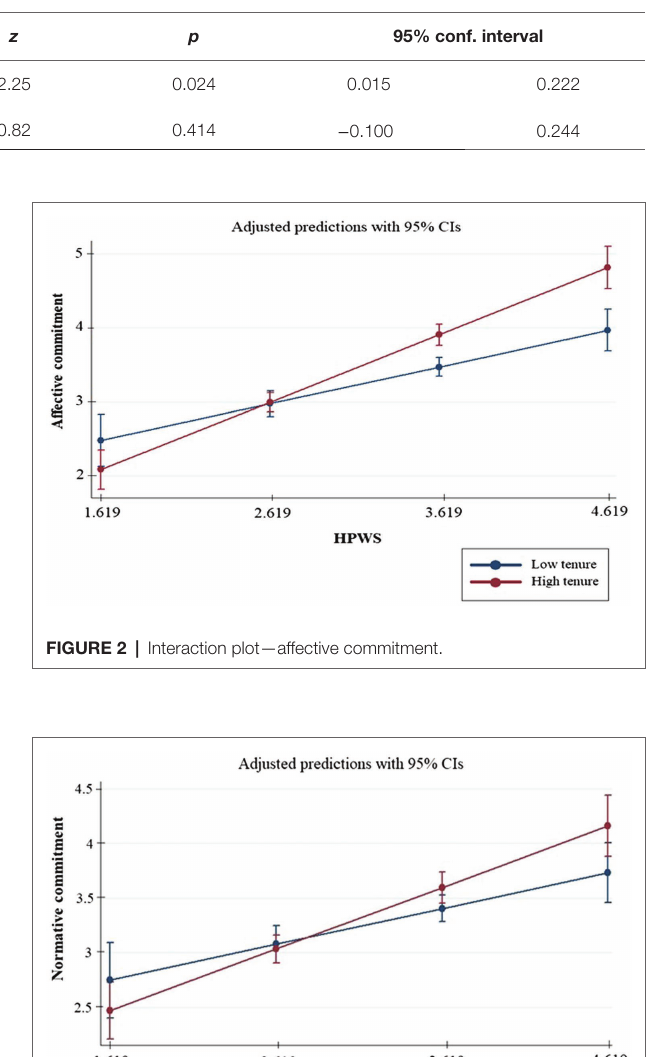
TABLE 4 | Indirect and total